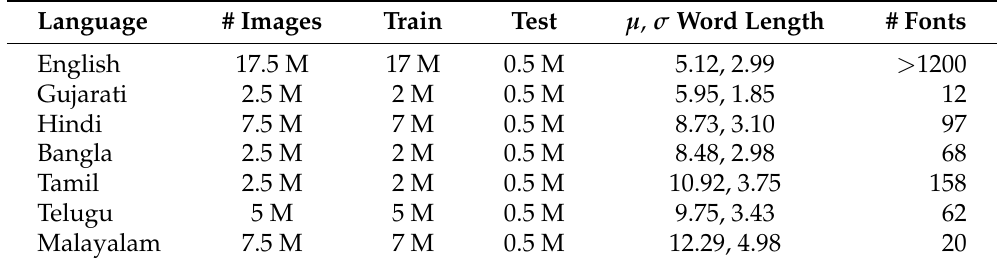
Figure 4. Clockwise from top-left: synthetic word images in Gujarati, Hindi, Bangla, Tamil, Telugu, and Malayalam. Notice that a top-connector line connects the characters to form a word in Hindi or Bangla. Some vowels and characters appear above and below the generic characters in Indian languages, unlike English. Table 1. Statistics of synthetic data. #, µ , σ represent number of samples, mean and standard